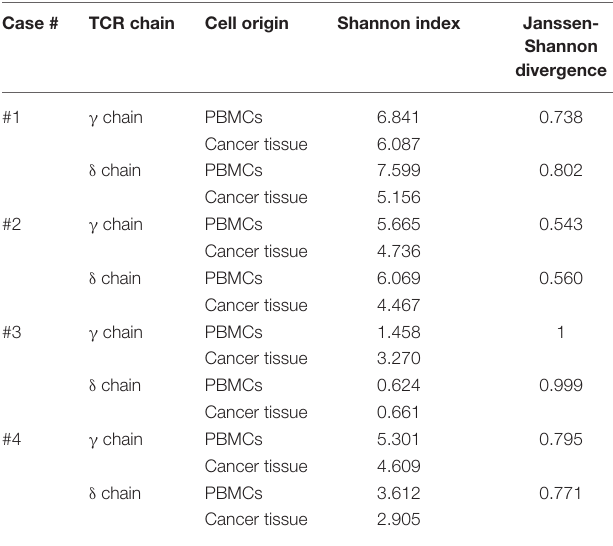
TABLE 2 | γδ T cell receptor repertoire diversity